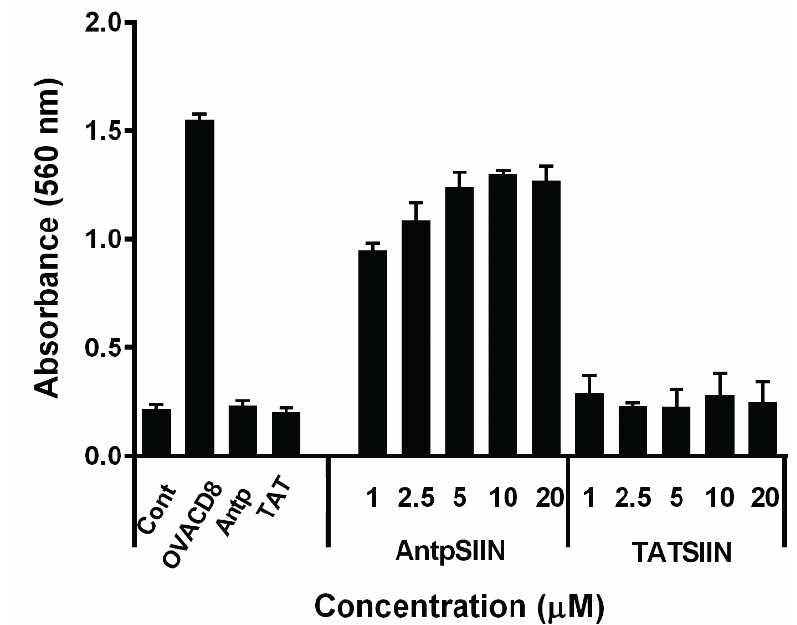
Figure 1. In vitro stimulation of T cells by AntpSIIN or TATSIIN pulsed bone marrow derived dendritic cells (BMDC). DC were incubated with AntpSIIN, TATSIIN, OVACD8, Antp, TAT peptide or media for 8 h and added to B3Z T cells for 18 h. LacZ activity in